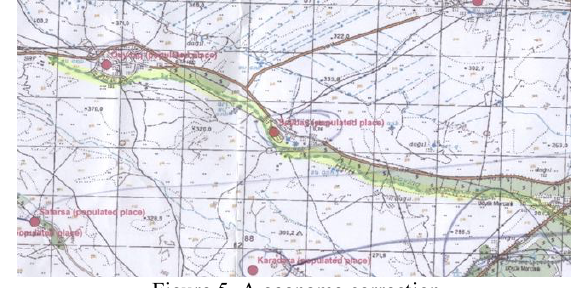
Figure 5. A geoname